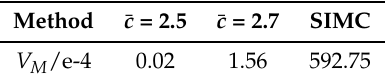
Figure 3. Reference example (Example 2). Consider PI control of the IPTD model, H p ( s ) = e − s The figure illustrates the trade-off between the Pareto performance objective J (Equation (41)) and robustness M s (Equation (10)). It illustrates the MP parameters ¯ c = 2.5 and ¯ c = 2.7 for Algorithm 1 proposed in Section 4. SIMC is added for comparison.